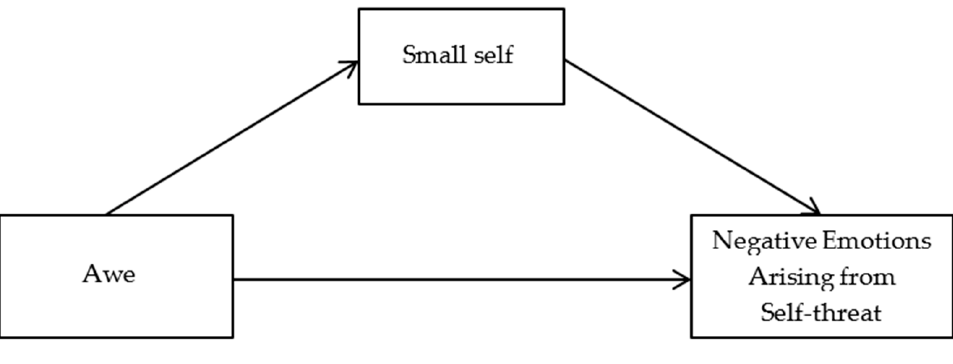
Figure 1. Conceptual